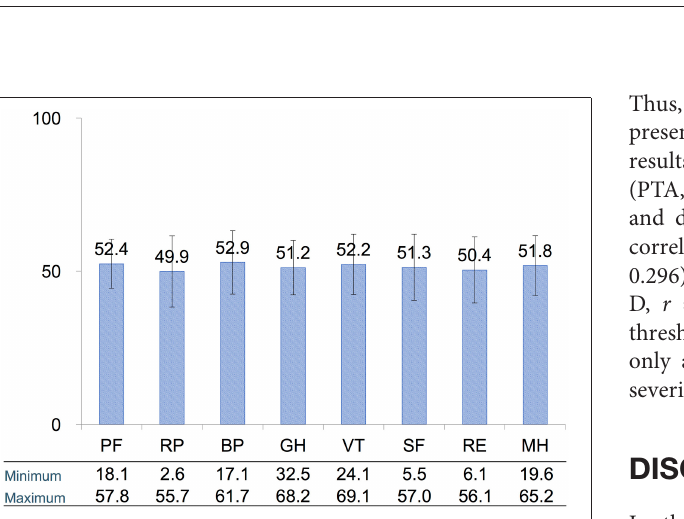
FIGURE 1 | Representative histograms of the distribution of the questionnaires for severity of VS-related symptoms. (A) scores of Tinnitus Handicap Inventory; (B) scores of Dizziness Handicap Inventory; (C) scores of Facial Clinimetric Evaluation Scale; (D) Visual Analog Scale for unilateral hearing impairment.